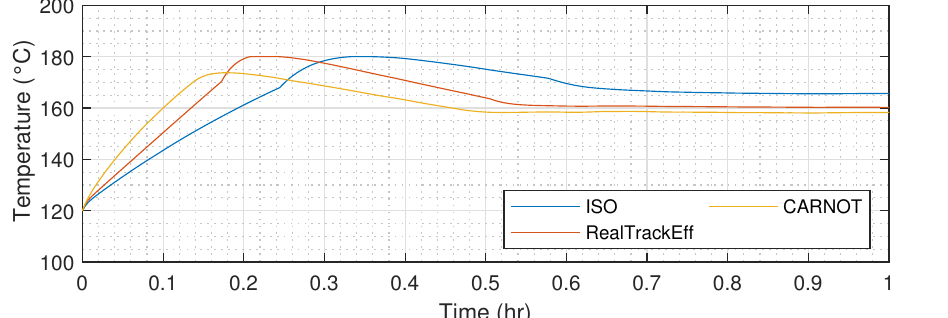
Figure 13. Outlet temperature of the HTF with the 3 modellings.